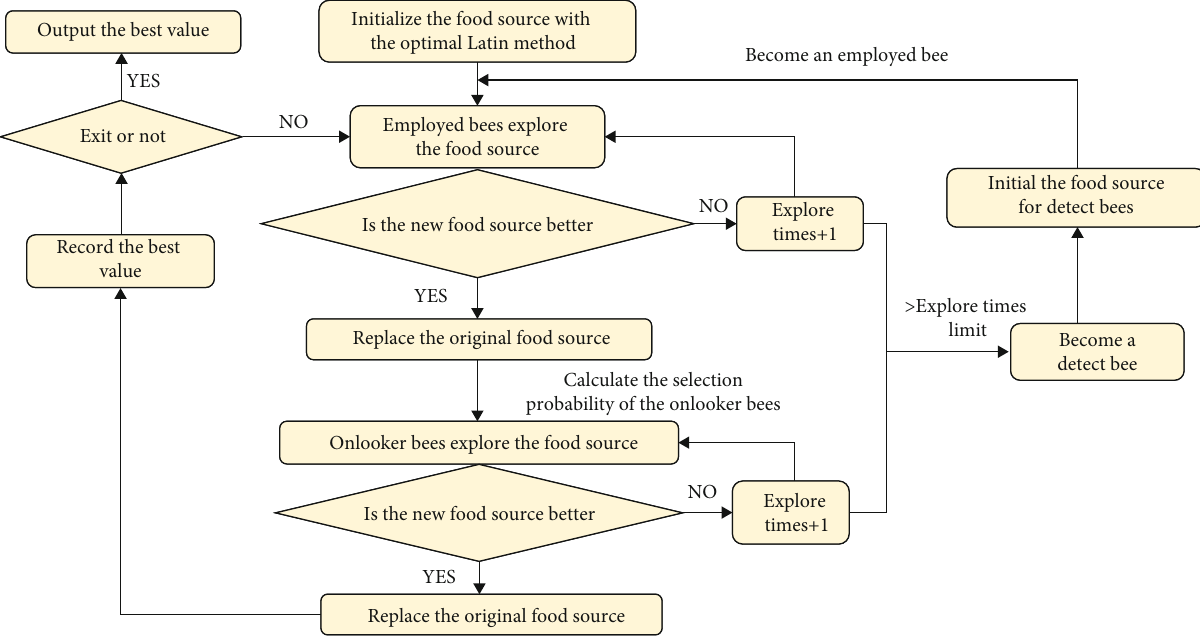
Figure 3: Schematic diagram of the IABC